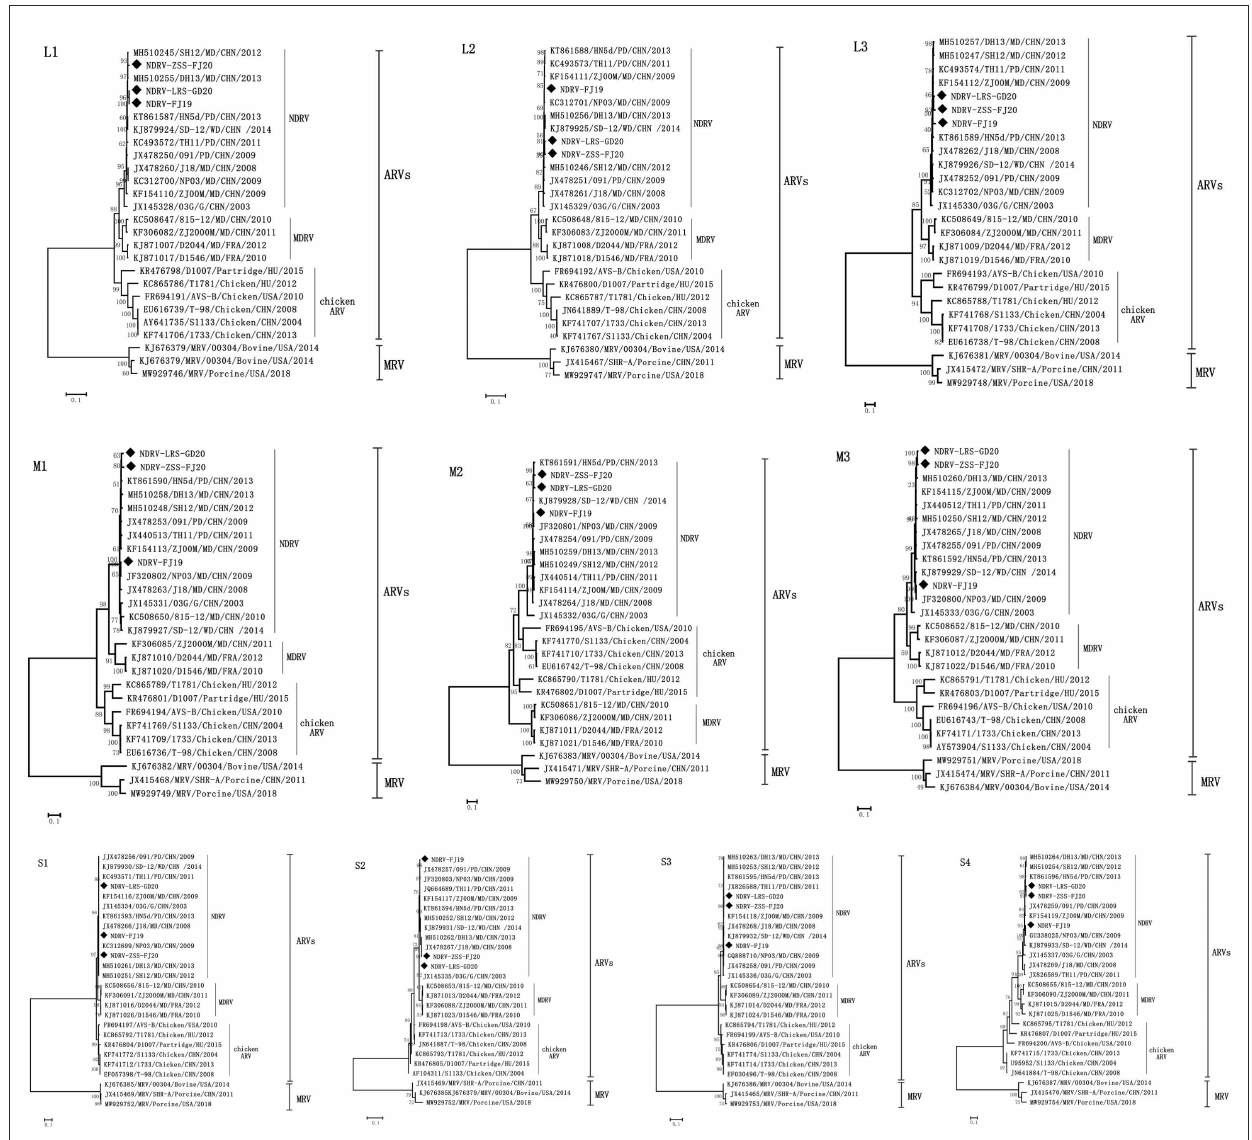
FIGURE4 Phylogenetic trees constructed based on the nucleotide sequences of the L, M, and S genome segments of different reoviruses. The three strains used in this experiment are shown as solid diamonds: NDRV-ZSS-FJ20, NDRV-LRS-GD20, and NDRV-FJ19. The scale is equal to the genetic distance between two